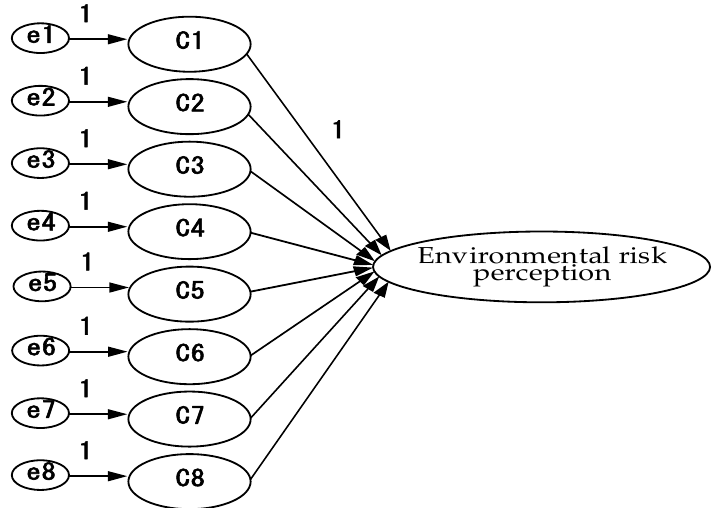
Figure 3. Environmental risk perception model—confirmatory factor analysis framework.